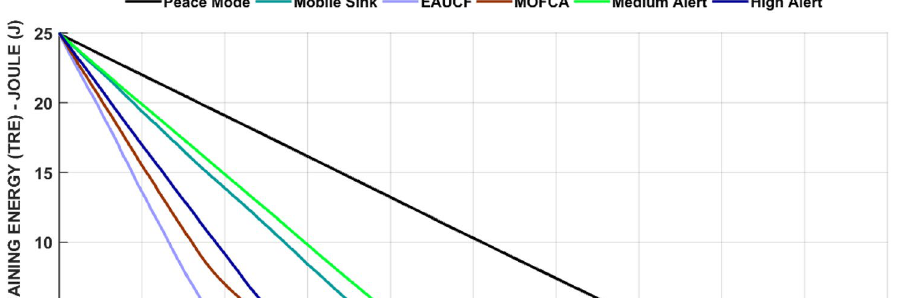
Fig. 7 Total remaining energy in relation to the number of